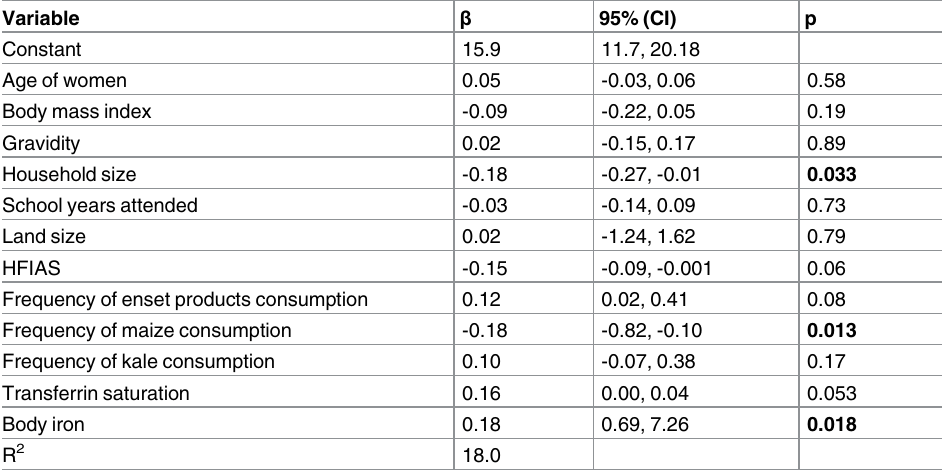
Table 5. Ordinary least-squares regression analysis for variables predicting hemoglobin concentra- tion in women of reproductive age in Sidama zone, southern